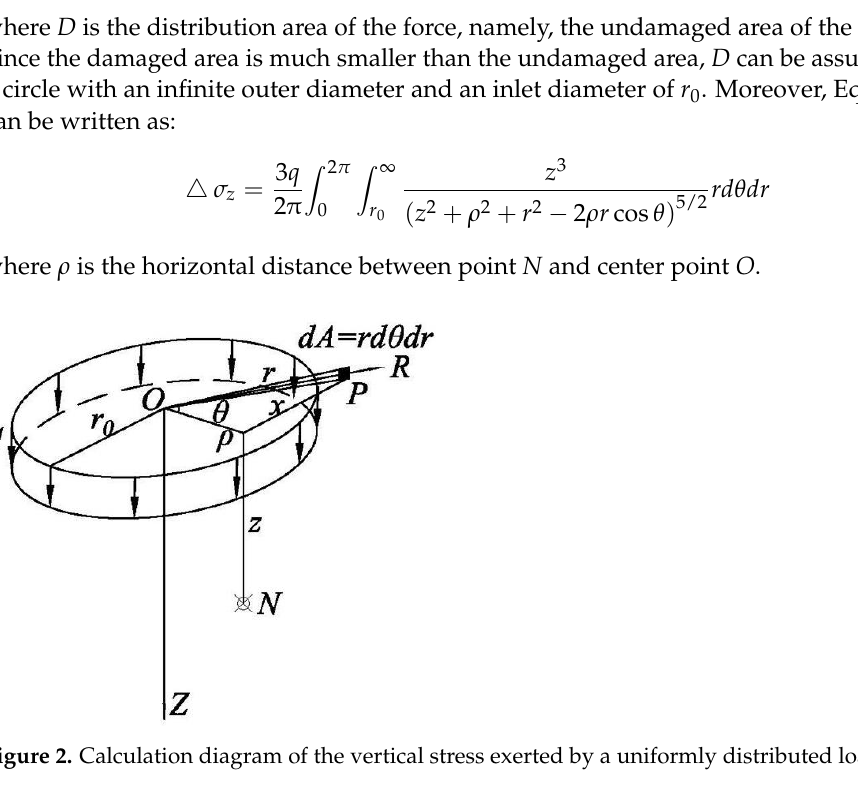
Figure 2. Calculation diagram of the vertical stress exerted by a uniformly distributed load.